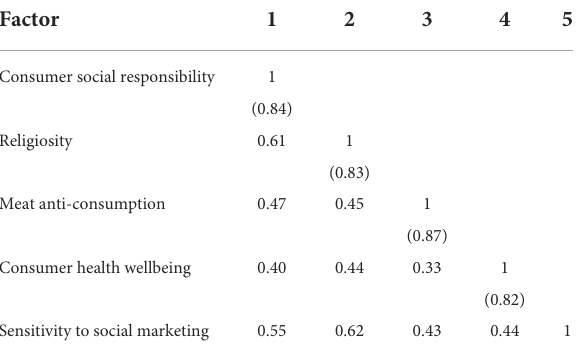
TABLE 2 Discriminant validity